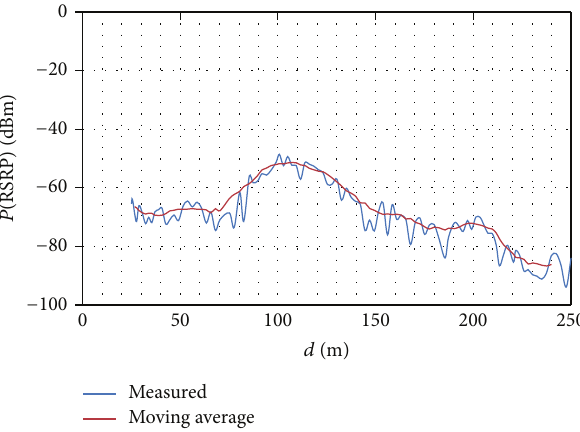
Figure7:Powerdensitydependingonthedistance 𝑥 fromtheBS,as computed with the free-space model and the case specific PL model. It is being considered that PL below the intercept point at 18m is equivalent to free-space propagation.